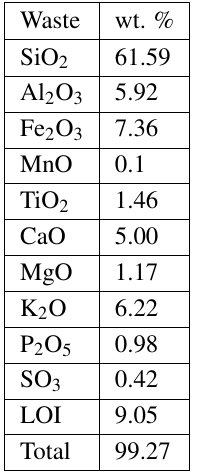
Table 2. Chemical composition of sugarcane bagasse waste